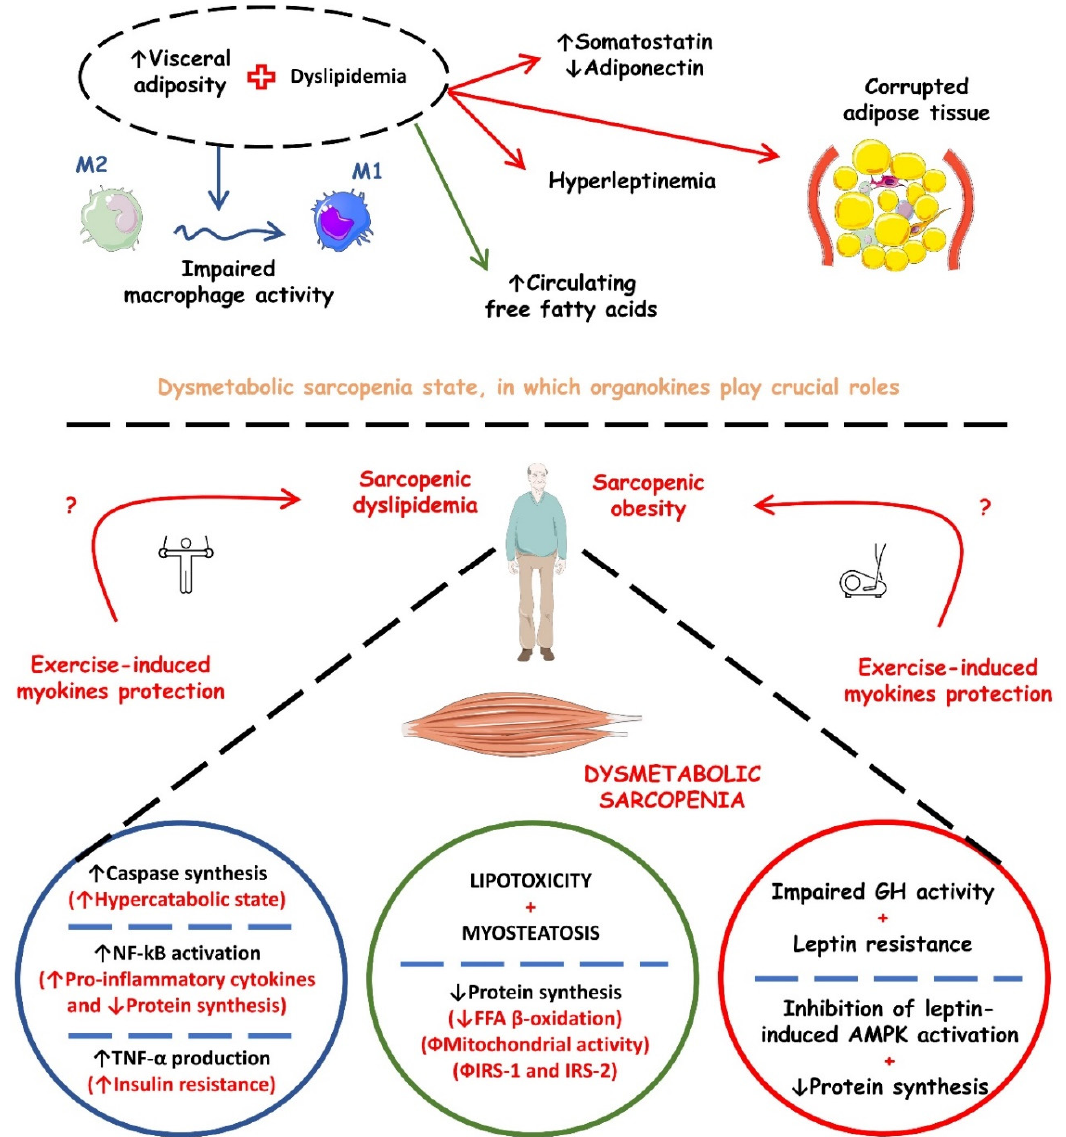
Figure 3. Possible mechanistic associations between organokines secretion and the occurrence of dysmetabolic sarcopenia. ↑ , increase; ↓ , decrease; AMPK, AMP (adenosine monophosphate)-activated protein kinase; FFA, free fatty acids; GH, growth hormone; IRS-1, insulin receptor substrate 1; IRS-2, insulin receptor substrate 2; NF-kB, nuclear factor kappa b; TNF- α , tumor factor necrosis